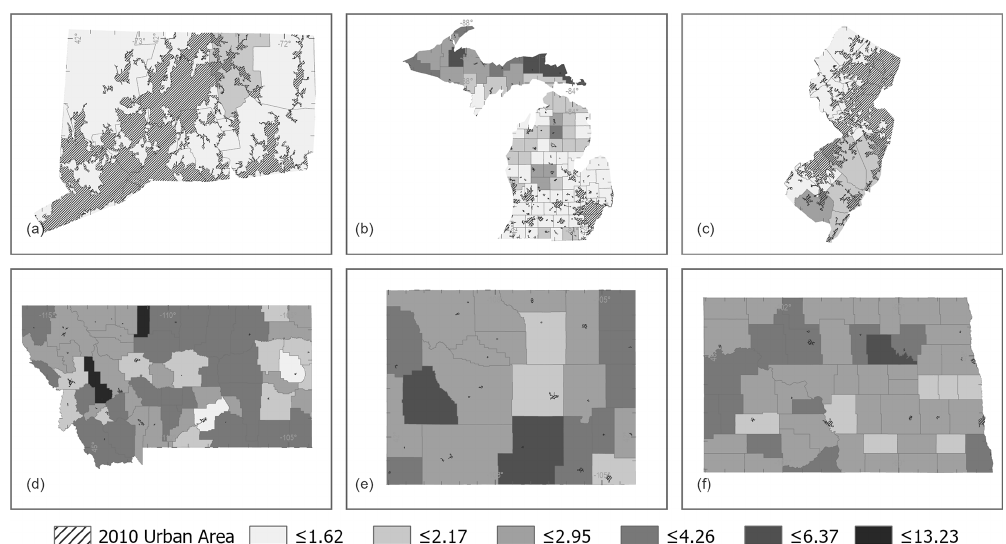
Figure 5. Census urban areas and county NRMSE between census block population count and the estimated block population count from IDM for some of the states with the lowest NRMSE ( (a) Connecticut, (b) Michigan, and (c) New Jersey) and highest NRMSE ( (d) Montana, (e) Wyoming, and (f) North Dakota).